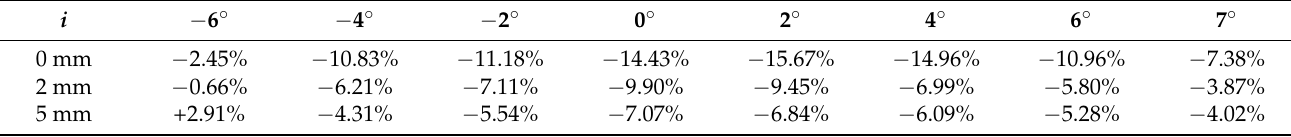
Table 5. The total pressure loss coefficient difference.